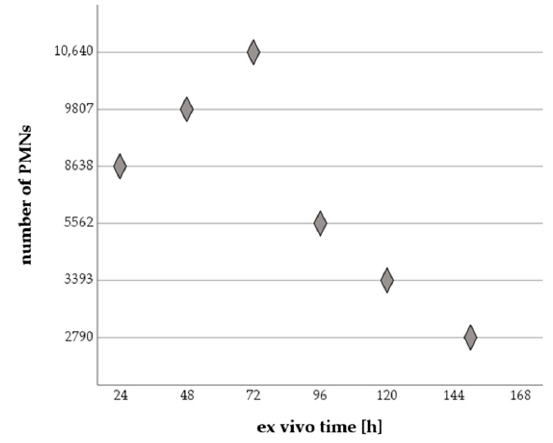
Figure 2. Total number of PMNs analyzed with increasing ex vivo time.